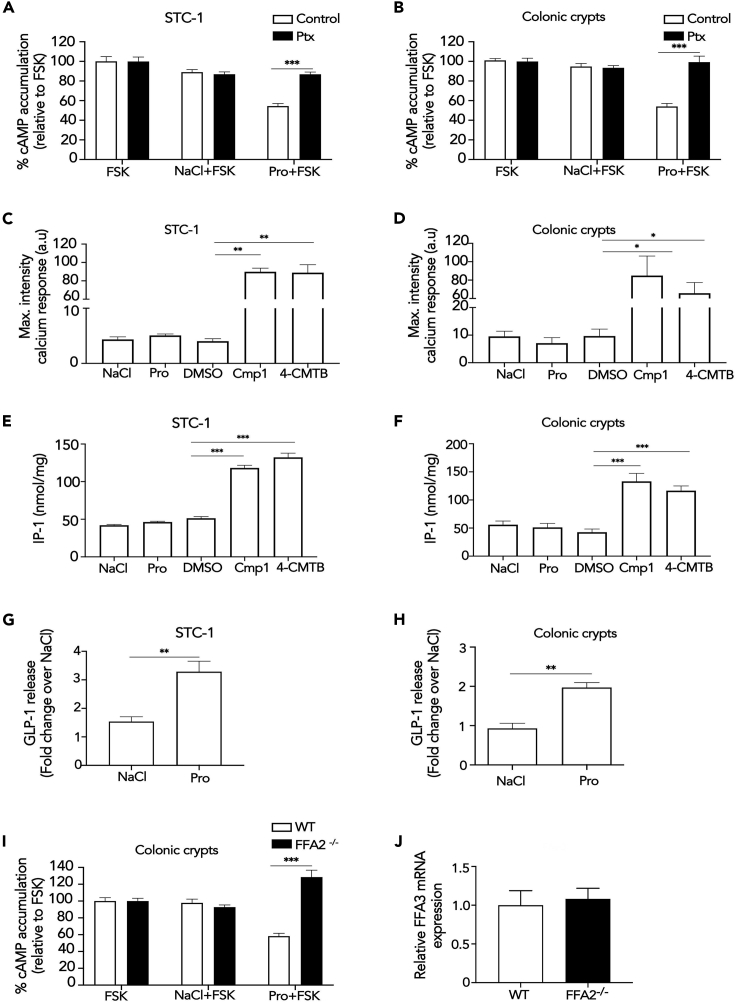
Propionate Stimulates GLP-1 Secretion and Activates Gαi/o but Not Gαq/11 via FFA2(A and B) Intracellular cAMP levels measured in STC-1 cells (A) or colonic crypts (B) pre-treated with Pertussis toxin (Ptx; 200 ng/mL, 20 h) prior to pre-treatment with IBMX (0.5 mM, 5 min) and then stimulated with forskolin (FSK, 3 μM) or a combination of FSK with either NaCl or sodium propionate (Pro) (1 mM, 5 min). Data are expressed as percent change of FSK-treated cells. n = 3 independent experiments. Two-sided Mann-Whitney U test, ∗∗∗p < 0.001.(C and D) Intracellular calcium mobilization measured in STC-1 cells (C) or colonic crypts (D). Cultures were incubated with calcium indicator Fluo4-AM for 1 h and imaged live via confocal microscopy for 1 min before the addition of NaCl (1 mM), sodium propionate (Pro), DMSO, orthosteric FFA2 agonist Cmp1 (10 μM), or allosteric FFA2 agonist 4-CMTB (10 μM). Average maximal intensities of n = 20 cells in duplicate per six independent experiments. Two-sided Mann-Whitney U test, ∗p < 0.05.(E and F) Intracellular accumulation of IP1 in STC-1 cells (E) or colonic crypts (F). Cultures were treated with NaCl, sodium propionate (Pro) (1 mM), DMSO, Cmp1 (10 μM), or 4-CMTB (10 μM) for 2 h. STC-1 cells or crypts, n = 3 independent experiments. Two-sided Mann-Whitney U test, ∗∗∗p < 0.001. Data represent mean ± SEM.(G and H) (G) STC-1 cells and (H) colonic crypts were treated with either NaCl or sodium propionate (Pro) (1 mM, 2 h STC-1, 1 h crypts), and total GLP-1 levels secreted were measured via RIA. Data are expressed as fold change of total GLP-1 and normalized to basal (NaCl) secretion within the same experiment. For STC-1 cells, n = 4 independent experiments. For crypts, n = 3 independent experiments. Two-sided Mann-Whitney U test, ∗p < 0.05, ∗∗p < 0.01.(I) Intracellular cAMP levels measured in colonic crypts from wild-type (WT) or FFA2 knockout mice (FFA2 −/−) pre-treated with IBMX (0.5 mM, 5 min) and then stimulated as in (C) and (D). Data are expressed as percent change of FSK-treated cells. n = 3 independent experiments. Two-sided Mann-Whitney U test, ∗∗∗p < 0.001.(J) Expression levels of FFA3 in WT and FFA2 −/− colonic crypts. mRNA isolated from colonic crypts of WT and FFA2 −/− mice were used in qPCR studies with specific mouse FFA3 primers. Data are presented as ΔΔCt. Two-sided Mann-Whitney U test. Data represent mean ± SEM.See also Figures S1–S4 and Videos S1, S2, and S3.